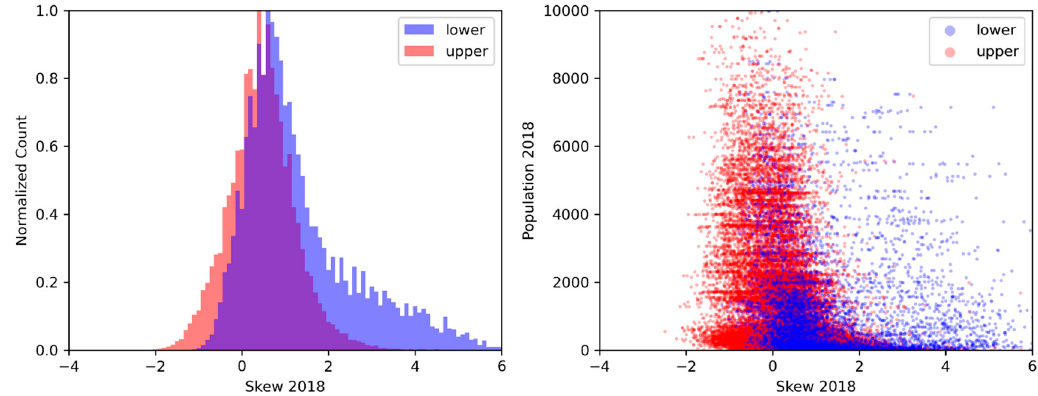
Figure 22. Histogram and scattergram of the 2018 skew values for the developing set (Harare, Nairobi, Dhaka, and Pyongyang) versus the developed set (Houston, Seoul, Shanghai, Beijing). The developed set is red and developing set is blue. The two sets are referred to as “lower” and “upper”, respectively. The sample set excludes grid cells deemed to be permanent background, where no lighting is detected. The scattergram is the skew versus population count from 2018.